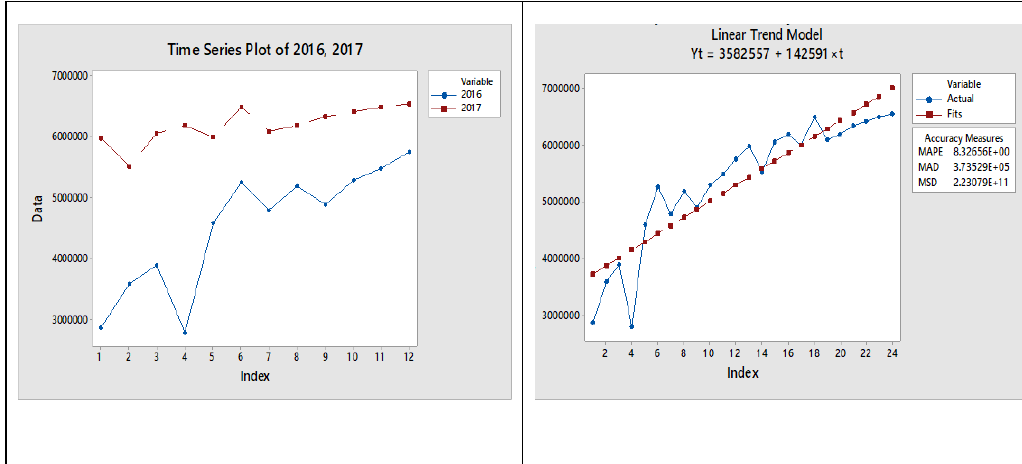
Fig. 3. Seasonal pattern and trend analysis for IGB.